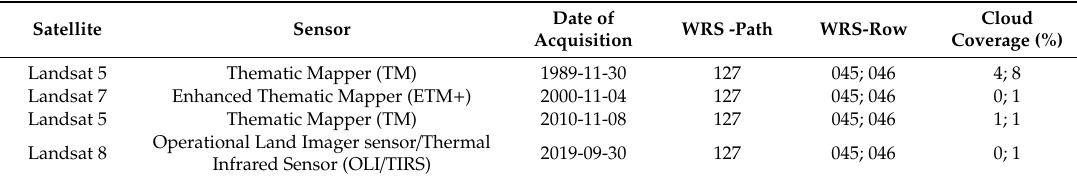
Table 1. The satellite image